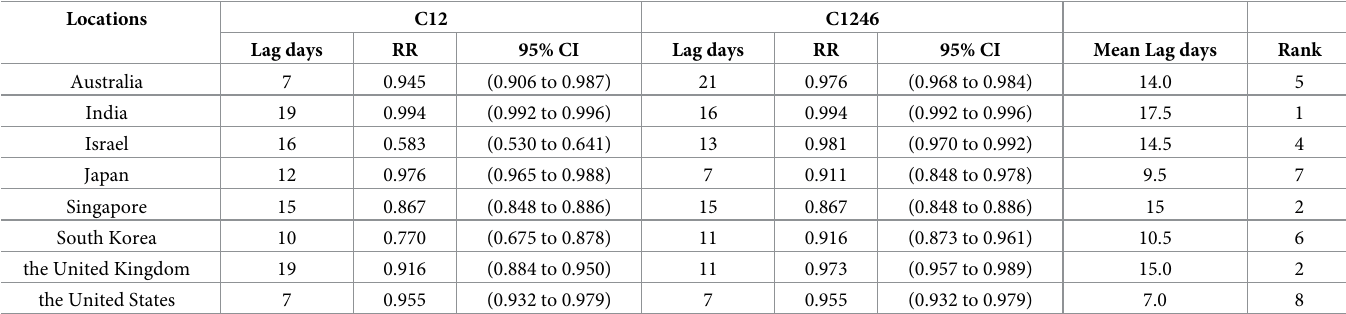
Table 2. The RR values and 95% confidence intervals of C1 and C2 or C1, C2, C4, and C6 with lag time in eight studies countries.